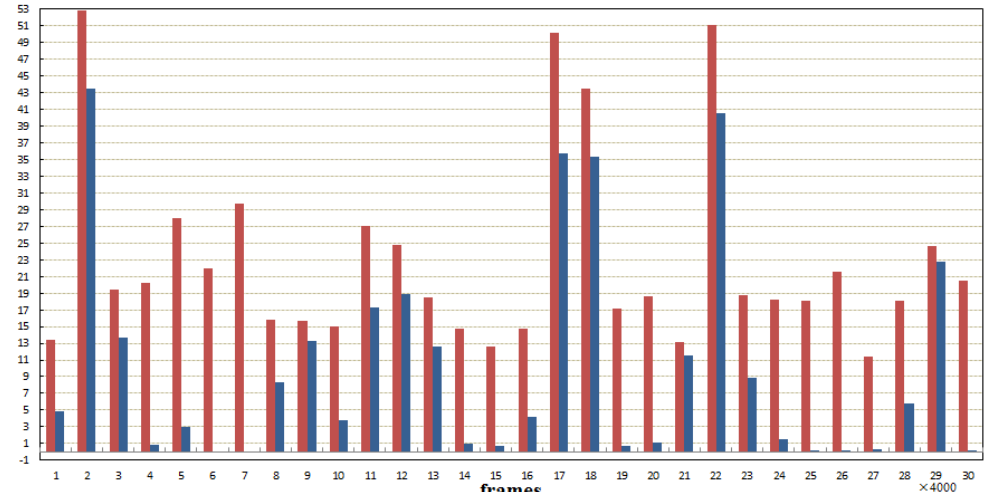
Figure 9. Comparison results with unsupervised extraction of video highlights via robust recurrent auto-encoders [27]. The red columns are the highlight values calculated by using the proposed method, and the blue columns are the results of [27]. It can be noticed that the proposed method can find more highlight